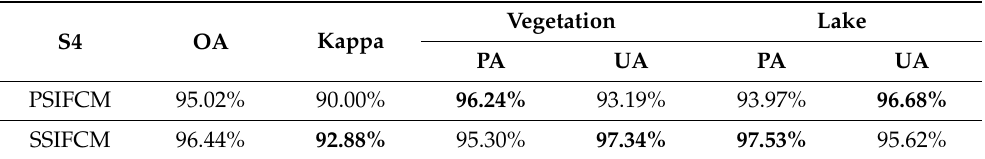
Table 4. Evaluation of S4 image pixel-level and object-level spatial intuitive fuzzy clustering algo- rithms classification